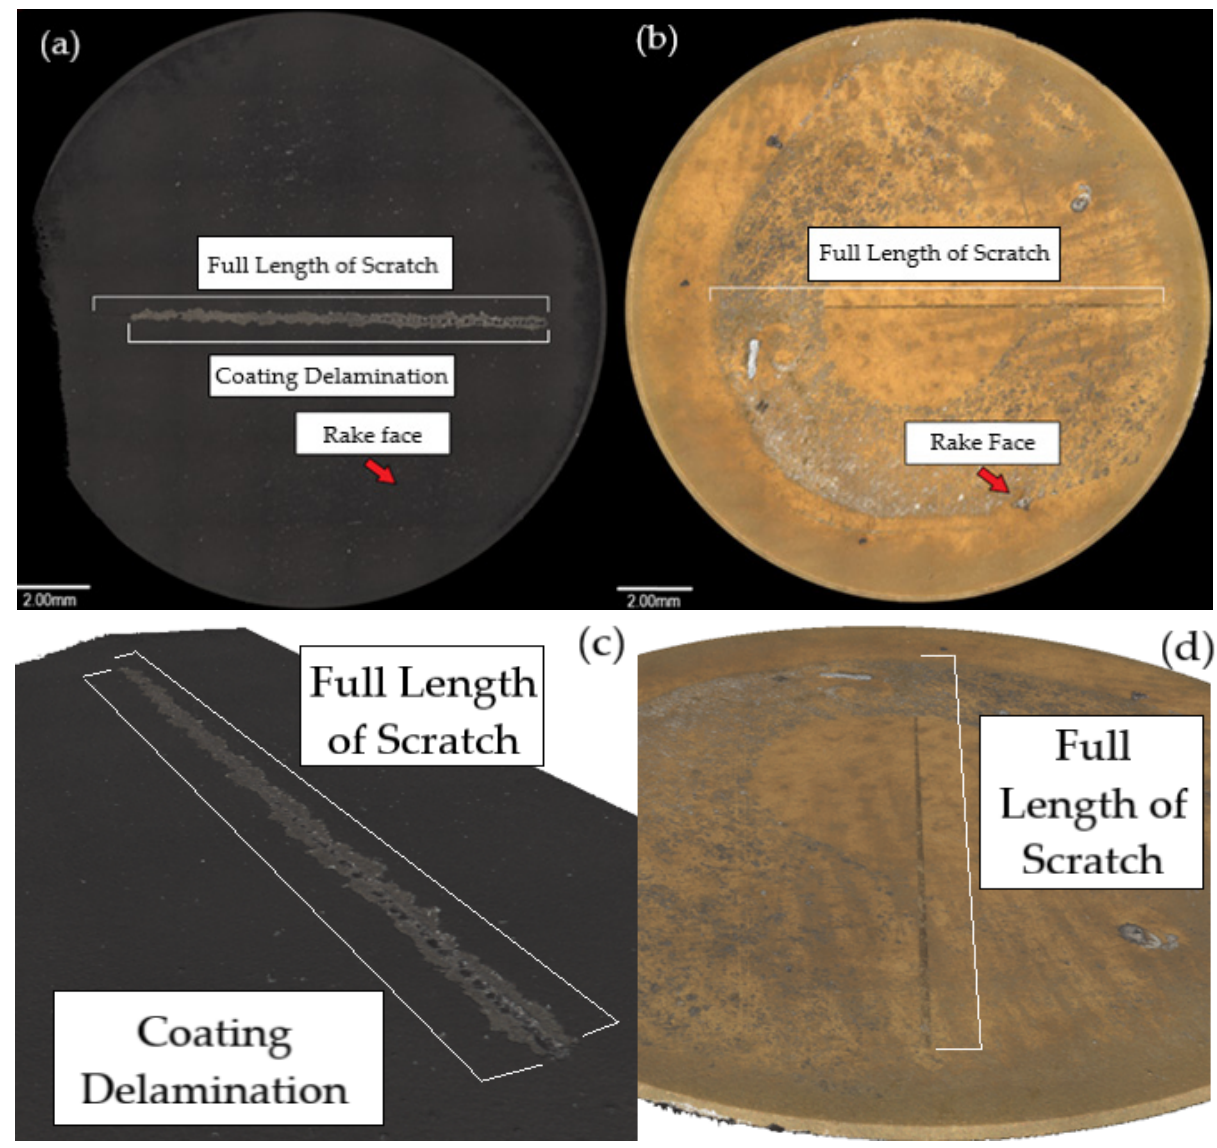
Figure 14. Non-contact 3D profilometer (focus — variation type) scan of ( a , c ) the Coating A scratch and ( b , d ) the Coating B scratch.